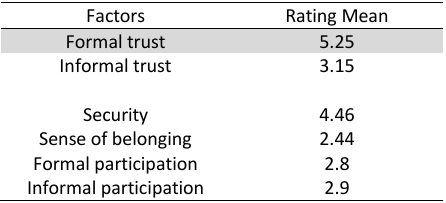
Table 8: Ranking and prioritizing the current state of architectural and physical spaces in the slums area of Zurabad of Karaj in reducing the social capital indicators